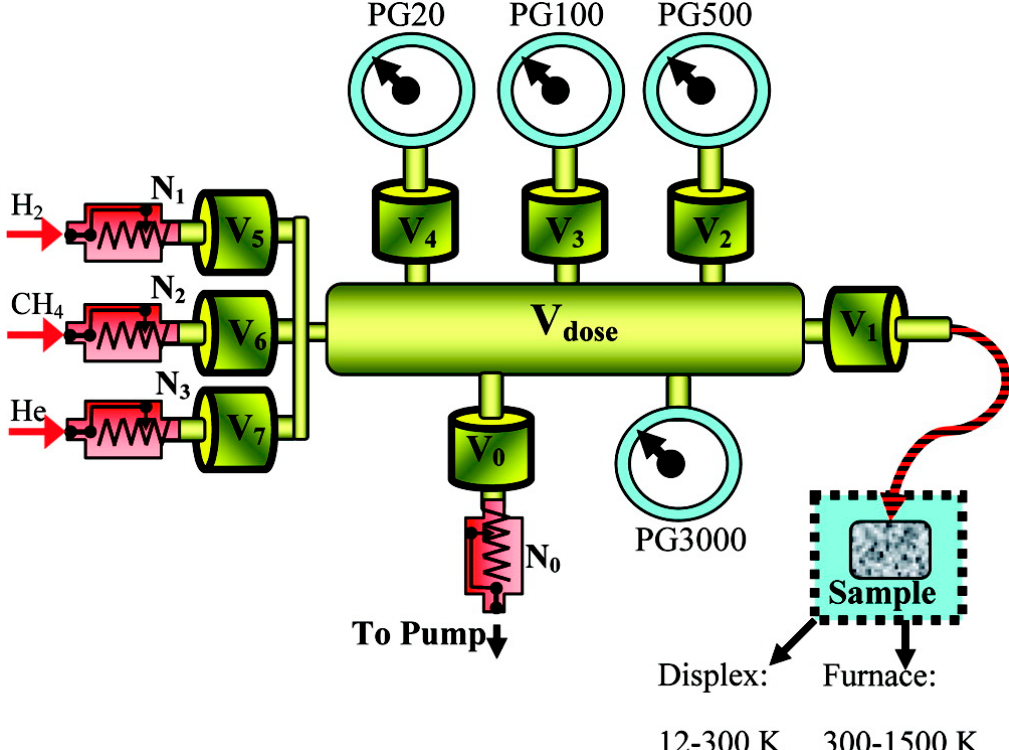
Figure 1. Schematic of Sieverts apparatus, including high-pressure valves (V 0 –V 7 ) and high-pressure needle valves (N 0 –N 3 ). The dosing volume is loaded into the system to a pressure which is monitored in addition to the temperature. The dosing volumes of Sievert apparatus may be around 13 cm 3 (including volumes of gauges) and the system is tested to prevent leaks. Adapted with permission from Ref. [40]. Copyright 2007 American Chemical Society.